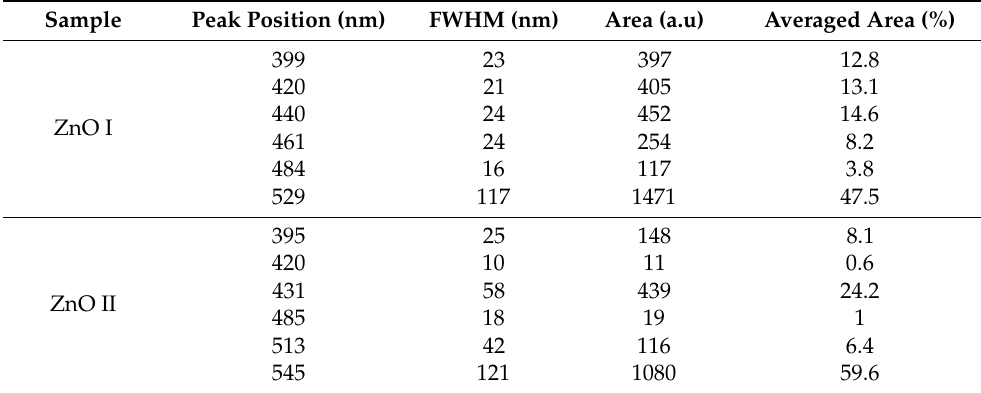
Table 6. PL deconvolution results on ZnO and AZO